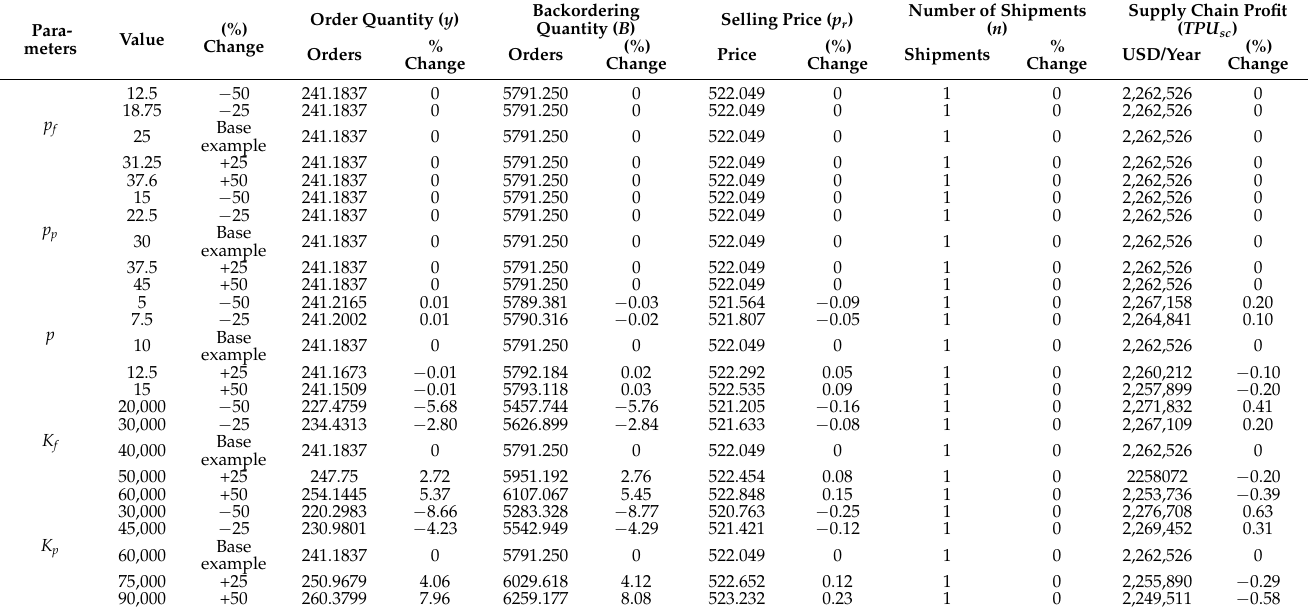
(cid:16) (cid:17) p f , p p , p , K f , K p on the optimal solution.